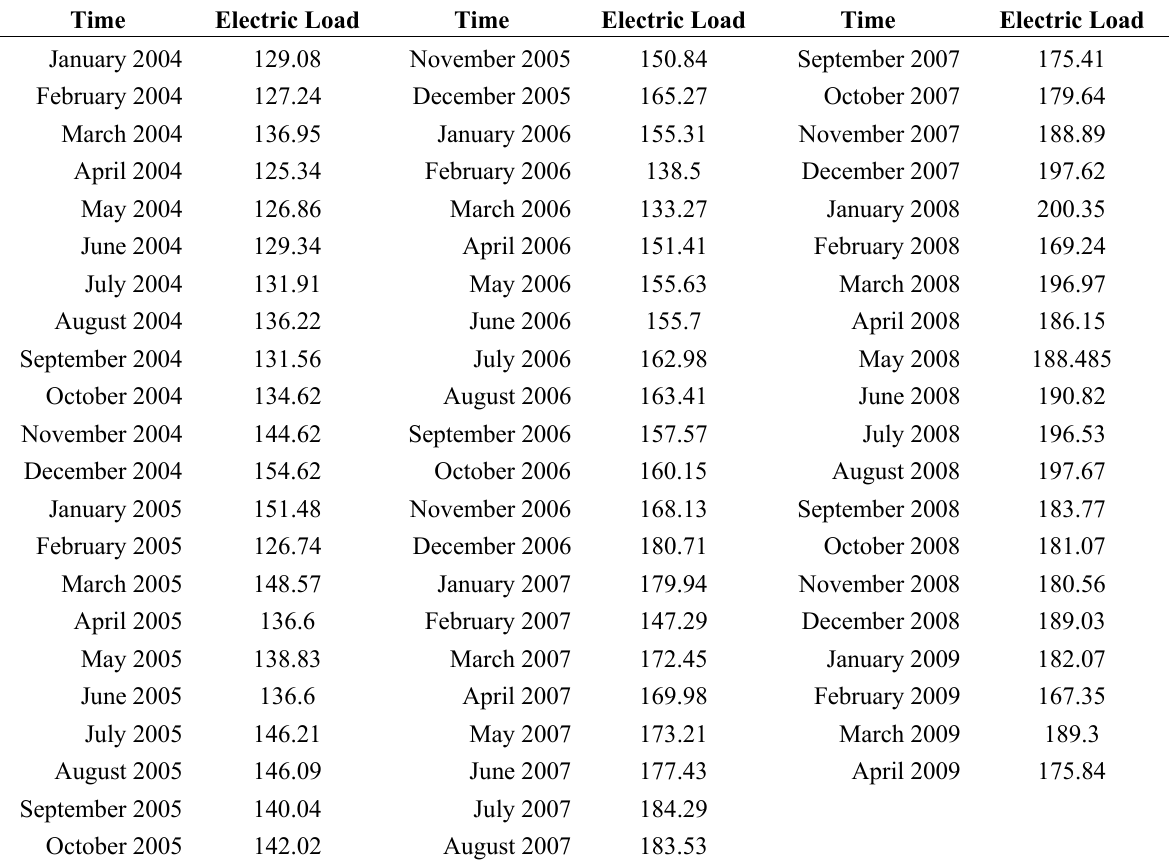
Table 1. Monthly electric load in Northeastern China (from January 2004 to April 2009). Units: hundred million